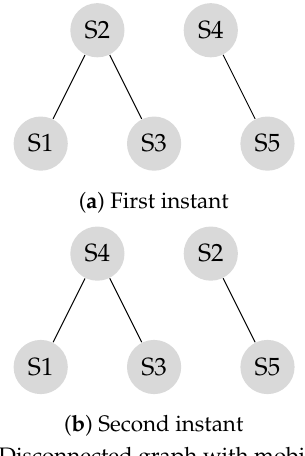
Figure 8. Disconnected graph with mobile